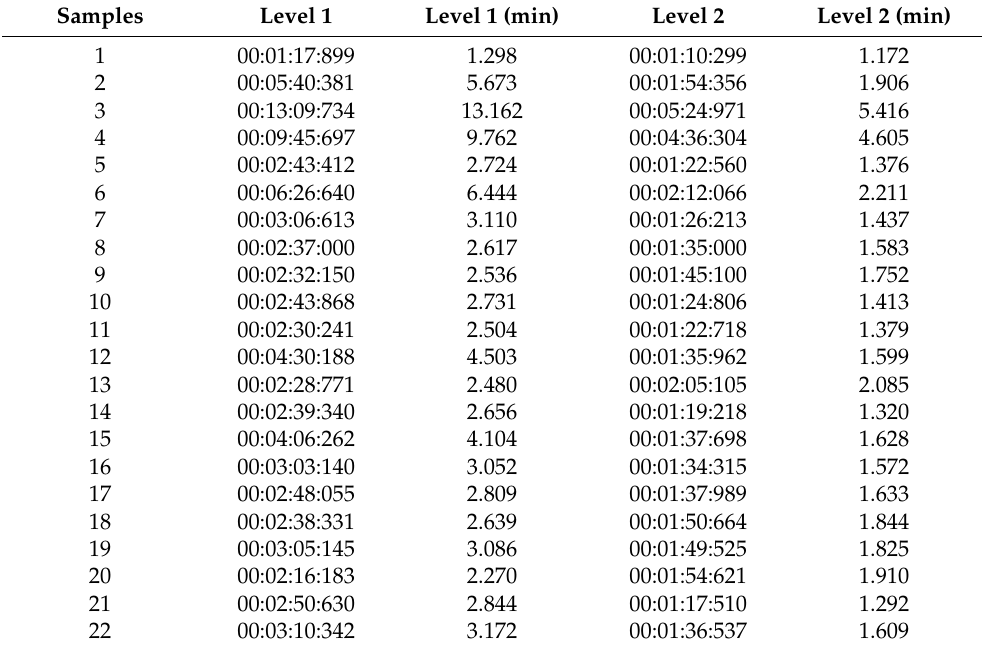
Table 9. Samples collected for Test 3, performed to measure the influence of AR visual hints in decreasing the circuit time for users that are controlling a UAV for the first time in an unknown trajectory.